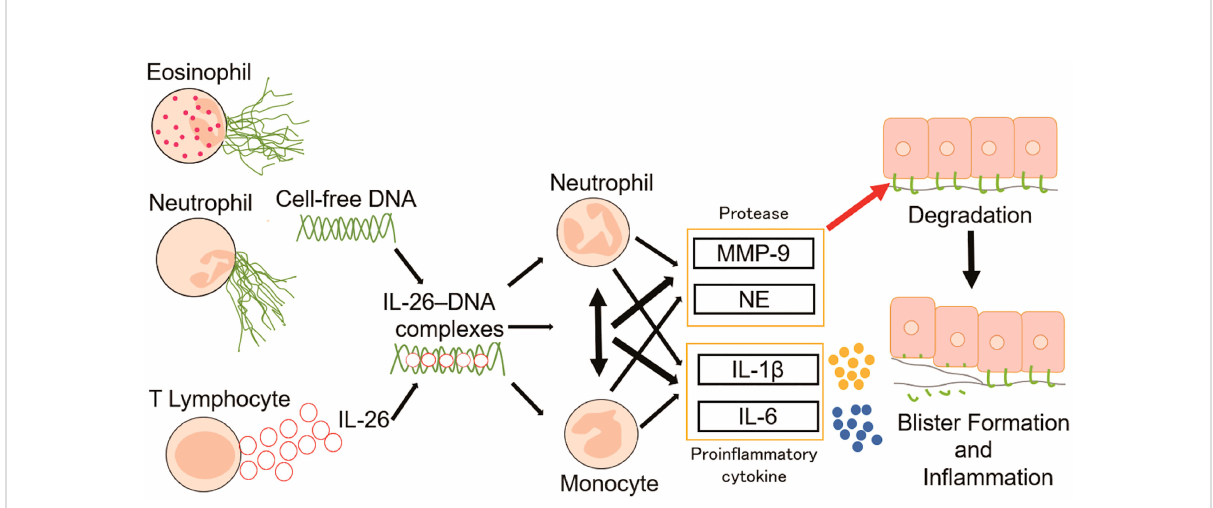
FIGURE 8 Proposed model for the role of IL-26 – DNA complexes in BP pathology. Extracellular DNA released from in fi ltrating eosinophils and neutrophils form complexes with IL-26 derived from CD3-positive lymphocytes. The resulting IL-26 – DNA complexes trigger the production of proteases (MMP-9 and NE) and proin fl ammatory cytokines (IL-1 b and IL-6) from monocytes and/or neutrophils. These proteases and proin fl ammatory cytokines promote degradation of hemidesmosomal protein BP180, resulting in the formation of subepidermal